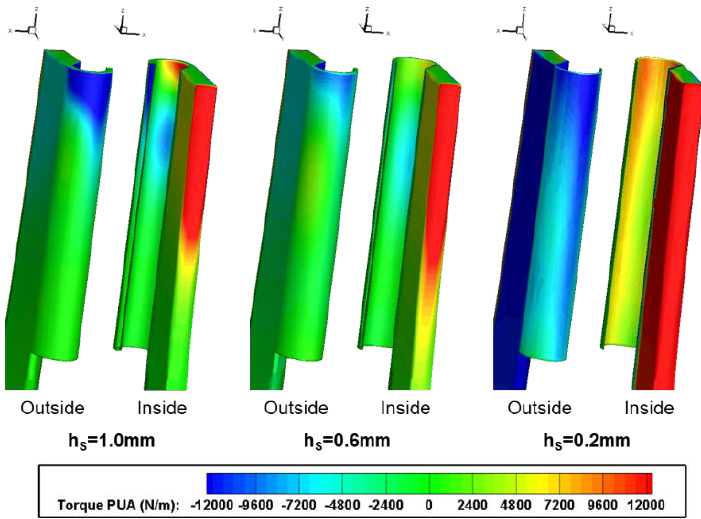
Figure 19. Torque PUA distribution of inner structure at C j = 0.125.